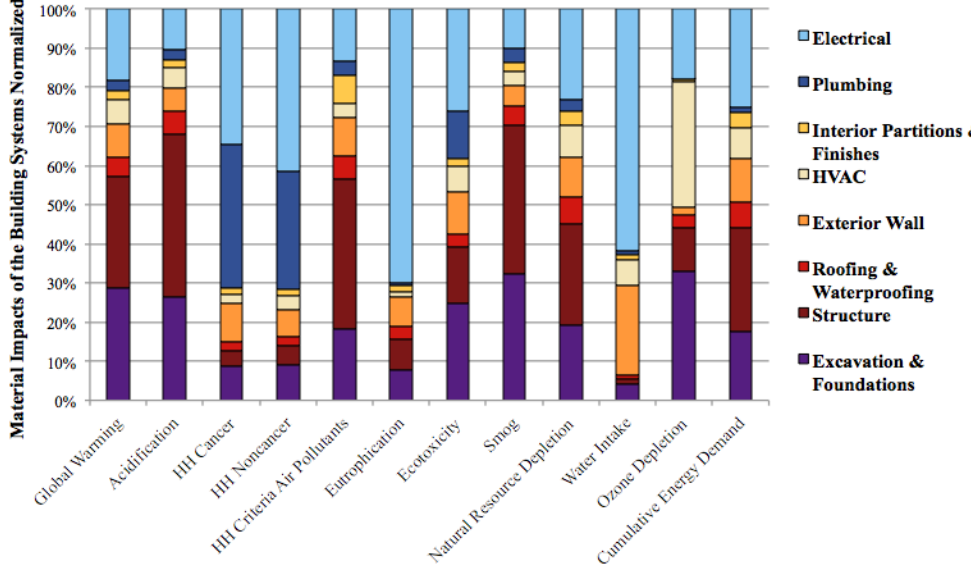
Figure 2. Life cycle impact of building materials by building system for net-zero energy building (HH = human health).